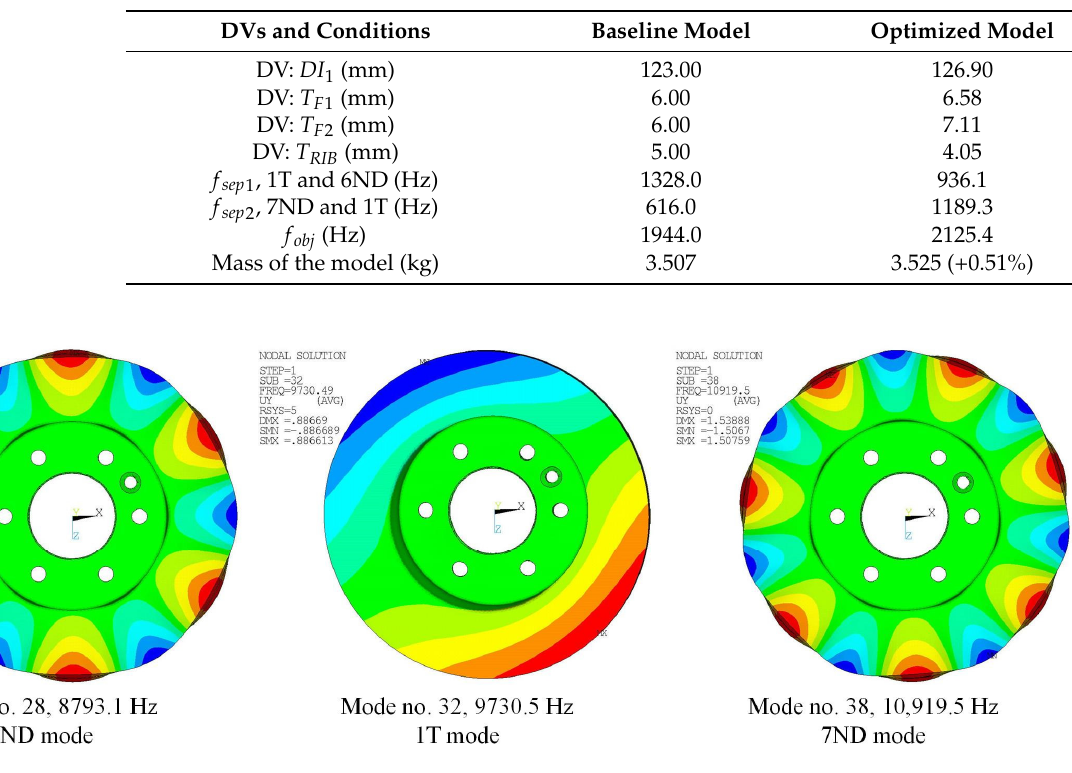
Figure 10. Optimized 6ND, 1T, and 7ND modes for Case